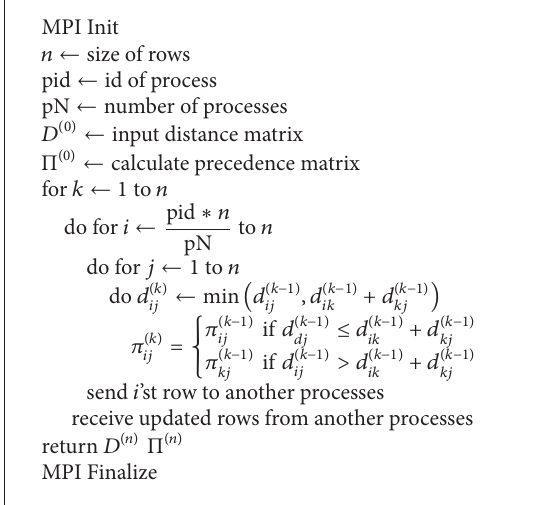
Algorithm 3: MPI pseudocode for the all-pairs-shortest-path